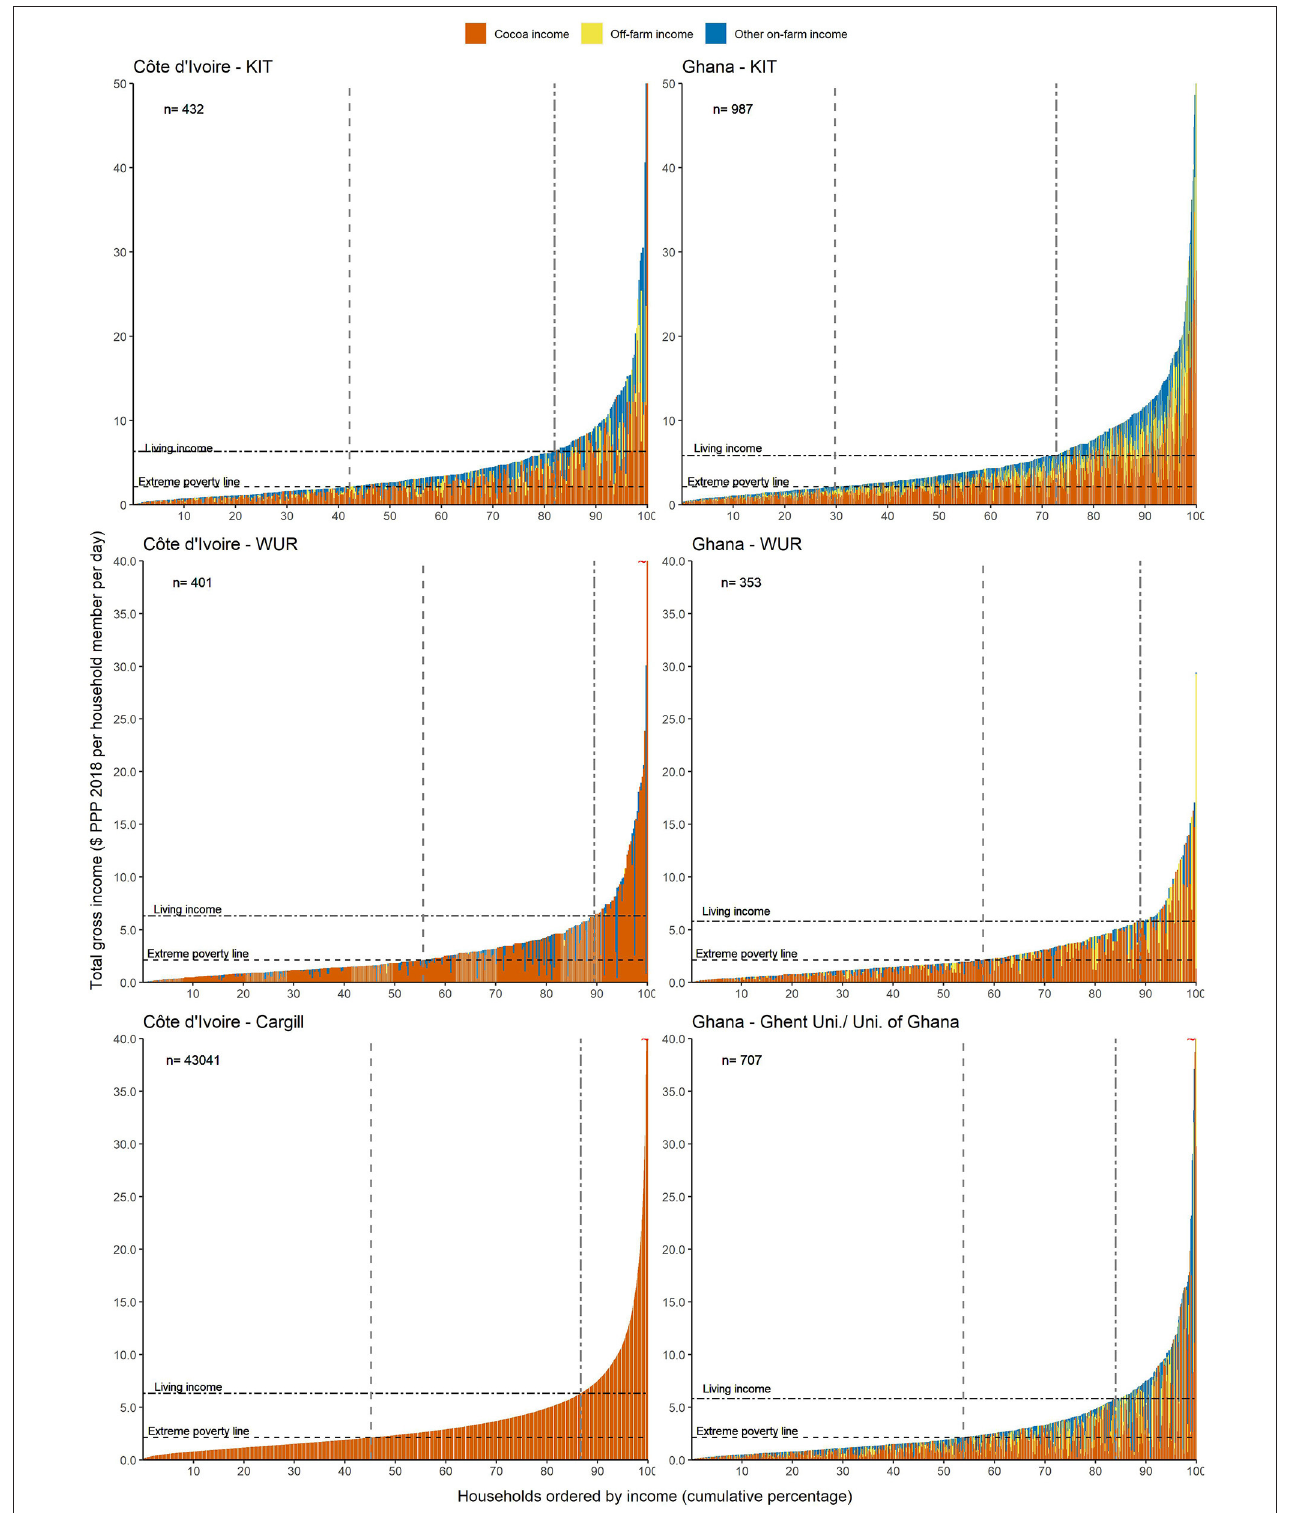
FIGURE 2 | Total gross income per household member per day ($ PPP 2018) for the six data sets, compared with the World Bank extreme poverty line and the Living Income benchmark in Ghana (based on Smith and Sarpong, 2018) and Côte d’Ivoire (based on CIRES, 2018). Note that only income from cocoa was recorded in the Cargill